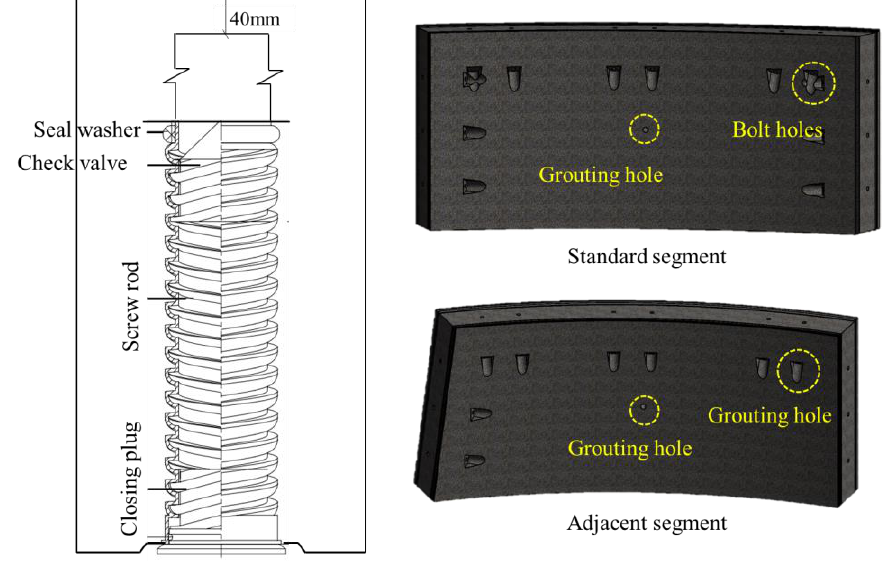
Figure 5. Characteristics of segment structure.